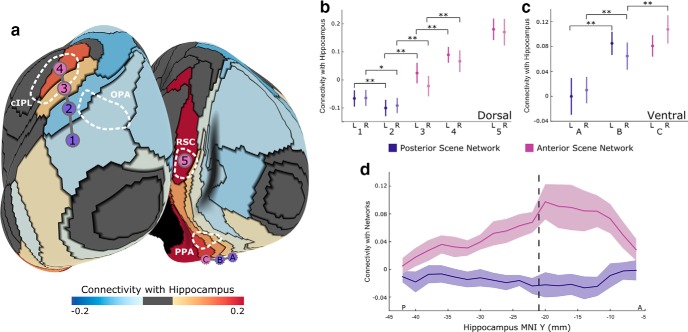
Connectivity between network parcels and the hippocampus. a, For each parcel in the anterior and posterior scene networks, we computed its resting-state connectivity with the hippocampus, showing a striking increase in hippocampal activity for anterior network parcels overlapping with cIPL, RSC, and aPPA (magenta circles) compared with posterior network parcels (blue circles). b, Along the dorsal network boundary, hippocampal activity first dips slightly and then increases substantially, becoming strongest in the most anterior parcel intersecting cIPL (and is also high in RSC). c, Ventrally along parcels overlapping with PPA, we observe a similar increasing posterior-to-anterior gradient in connectivity. d, Computing the connectivity between each coronal slice of the hippocampus and the two scene networks shows that this increased coupling to the anterior network is present throughout the hippocampus, but is especially pronounced in anterior hippocampus (MNI coordinate y > −21 mm). Error bars are 95% confidence intervals across subjects. *p < 0.05, **p < 0.01.